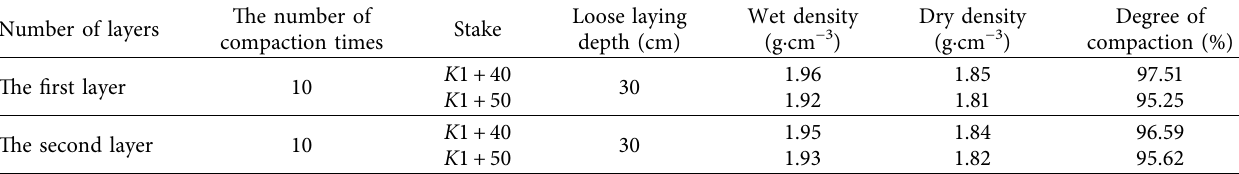
Figure 11: Construction process of the FSW subgrade: (a) roughly leveling with a bulldozer; (b) watering with a sprinkler; (c) static compaction and weak vibration. Table 7: Test results of compactness of FSW.